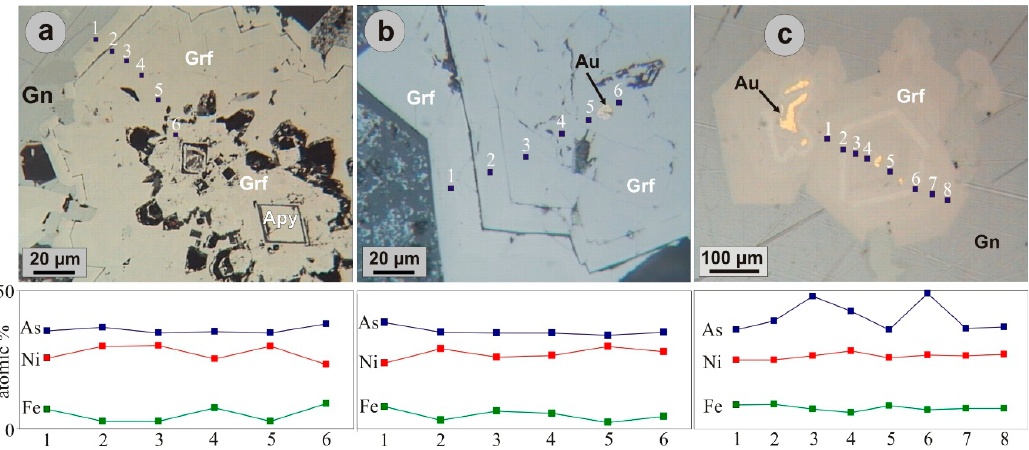
Figure 6. Electron probe microanalyses line scans of As, Ni, Fe distribution along traverses in gersdorffite. Minerals 2018 , 8 , x FOR PEER REVIEW